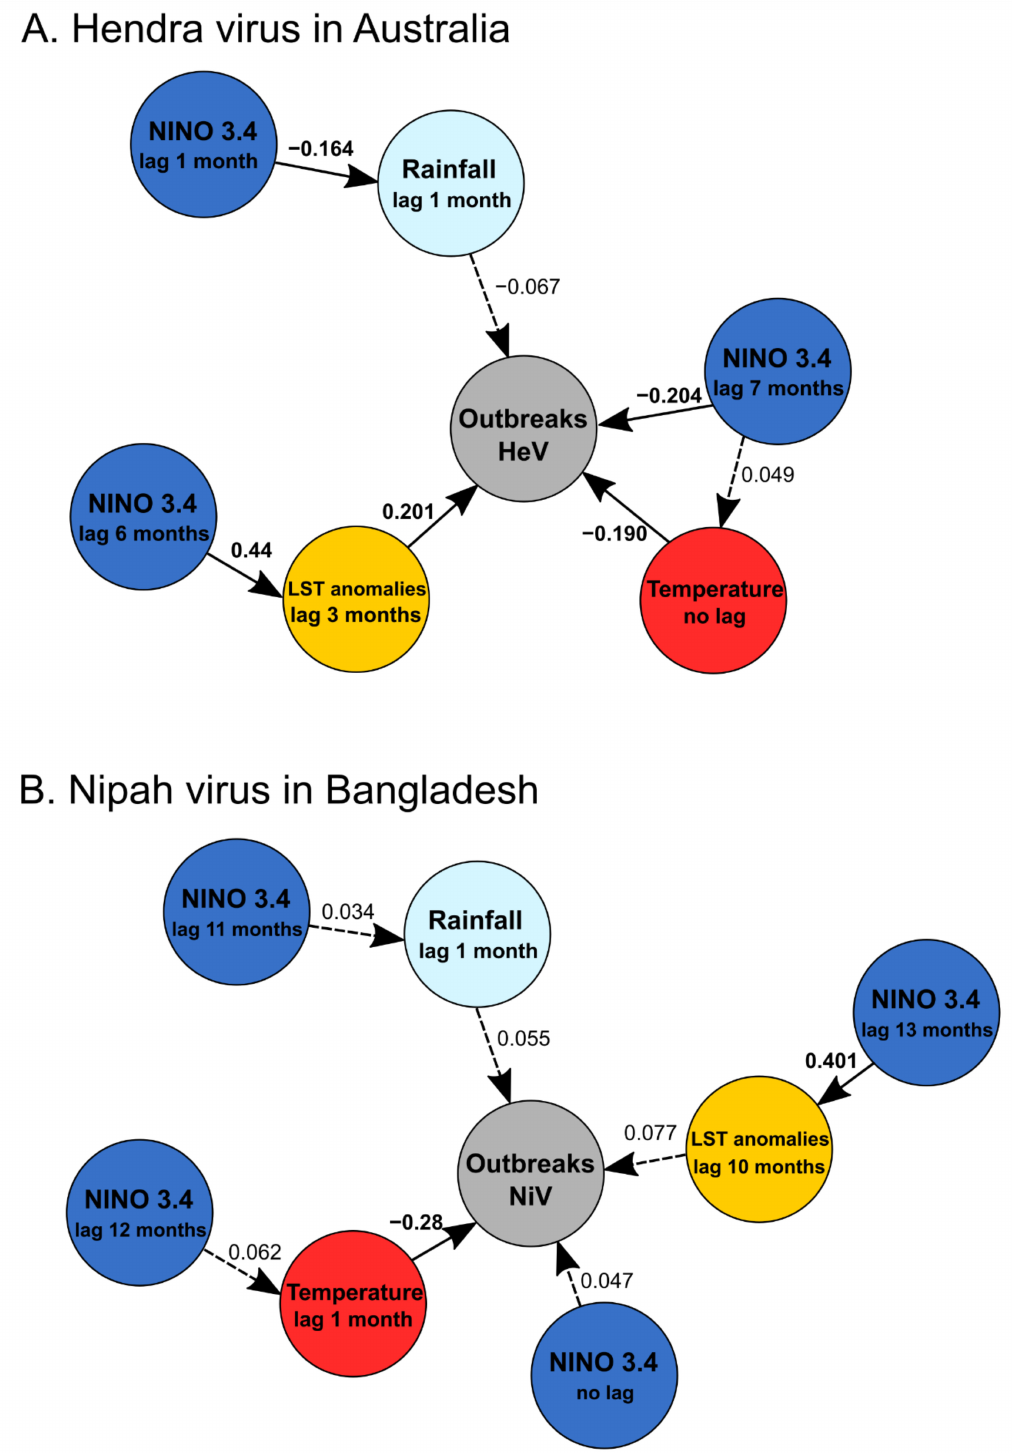
Figure 4. Results of structural equation modelling of ( A ) spillover events of the Hendra virus in Australia and ( B ) spillover events of the Nipah virus in Bangladesh on temporal trends from January 1993 to June 2020 (330 months) based on results obtained from temporal series analyses (Figure 2) and logistic regression analyses with lags (Table 4). Significant partial correlations are presented in continuous lines and non-significant partial correlations are presented in dashed lines with values of standardized